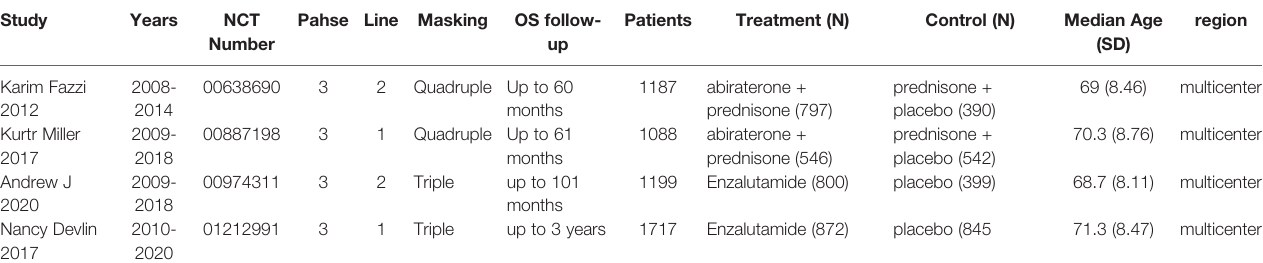
TABLE 1 | Characteristics of the eligible